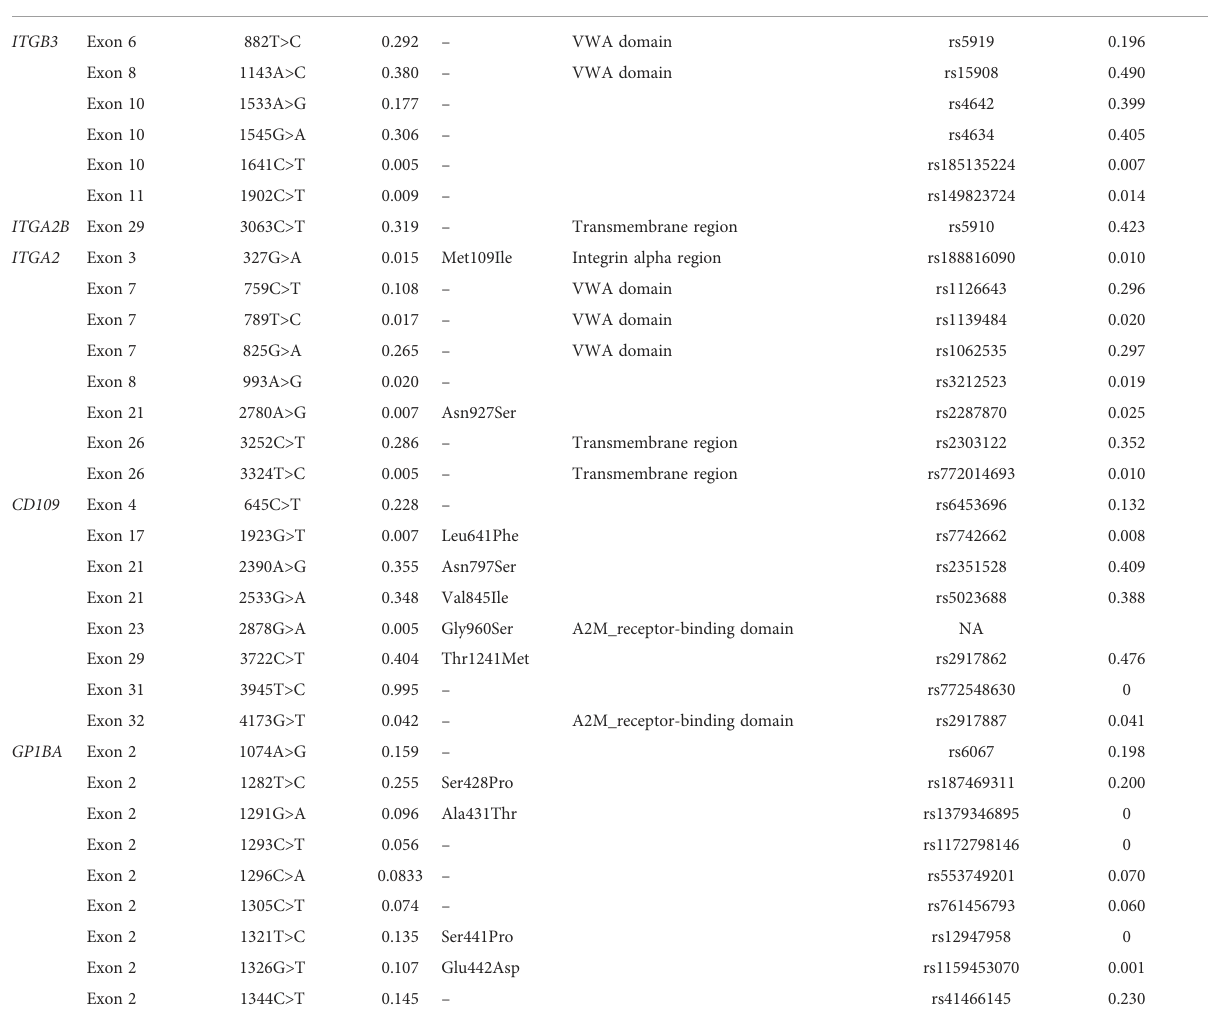
Predicted domains, repeats, motifs, SNP ID MAF of East substitution and features